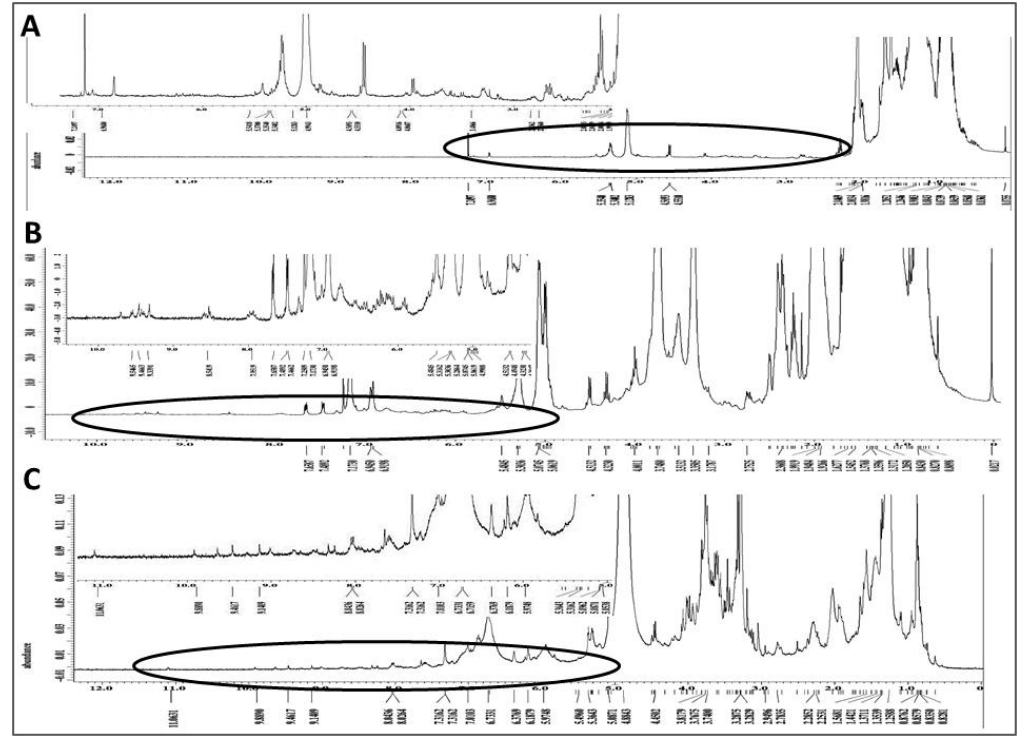
Figure 6. Phytochemical fingerprint of MeOH, DCM and Hexane extracts: 1 H NMR spectra of graviola extracts in CDCl 3 at 400 MHz. ( A ) Spectrum of the n -hexane subfraction and expansion of its circled downfield segment at upper left of panel; ( B ) Spectrum of the DCM subfraction and expansion of its circled downfield segment rich in olefinic, aromatic, heteroaromatic, phenolic hydroxy and/or NH groups; and ( C ) MeOH extract spectrum in CD3OD and expansion of its circled downfield segment rich in aromatic and phenolic hydroxy groups.